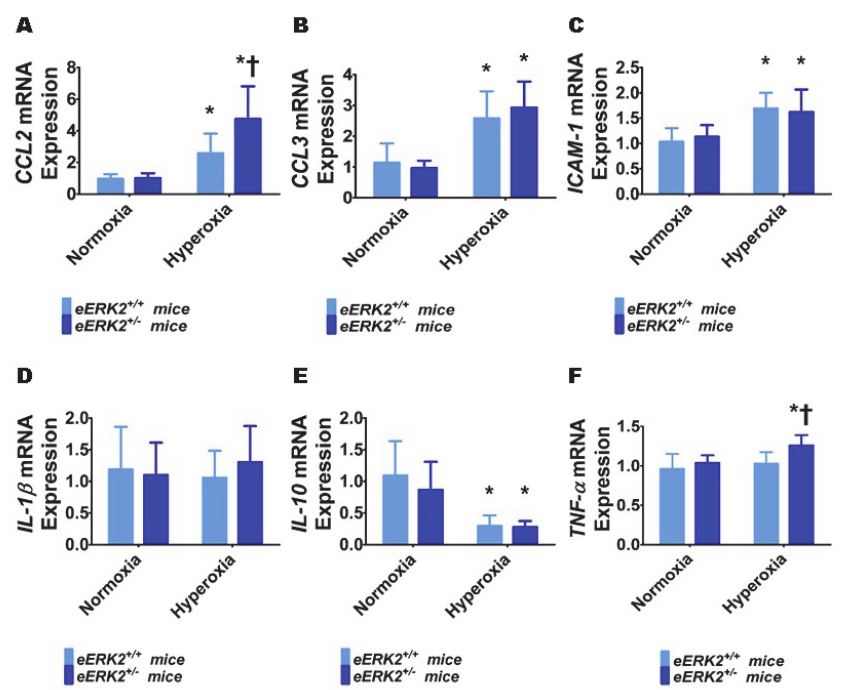
Figure 6. Lung inflammation in endothelial ERK2 -su ffi cient ( eERK2 +/+ ) or –deficient ( eERK2 +/ − ) mice exposed to hyperoxia. One-day-old eERK2 +/+ or eERK2 +/ − mice were exposed to either 21% O 2 (normoxia) or 70% O 2 (hyperoxia) for one week, following which the lung tissues were harvested for gene expression studies. ( A – F ) RT-PCR analyses-based determination of CCL2 ( A ), CCL3 ( B ), ICAM-1 ( C ), IL-1 β ( D ), IL-10 ( E ), and TNF- α ( F ) mRNA levels. Values are presented as mean ± SD ( n = 5–6 / genotype / exposure). Significant di ff erences between eERK2 +/+ and eERK2 +/ − mice in hyperoxic conditions are indicated by † , p < 0.05. Significant di ff erences between normoxia and hyperoxia groups are indicated by *, p < 0.05